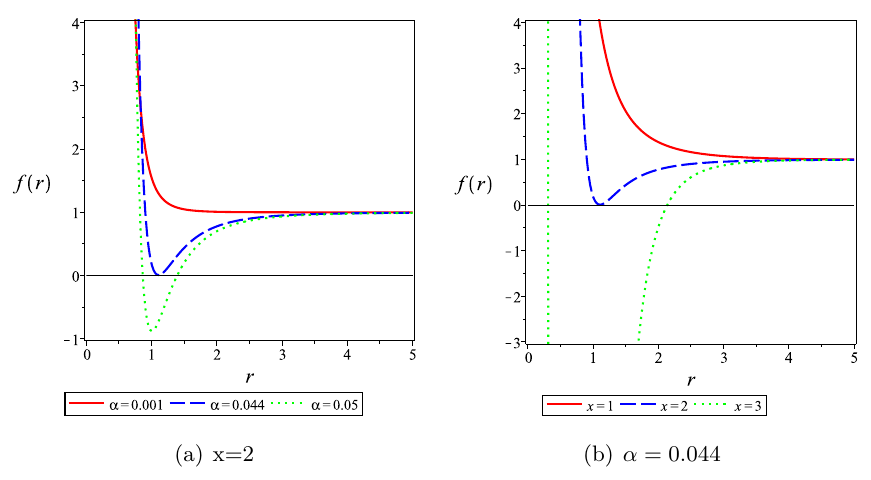
Figure 9 . Behavior of f ( r ) versus r for k = − 1 , n = 6 , G = 1 and M = 5 for “ + ” sign